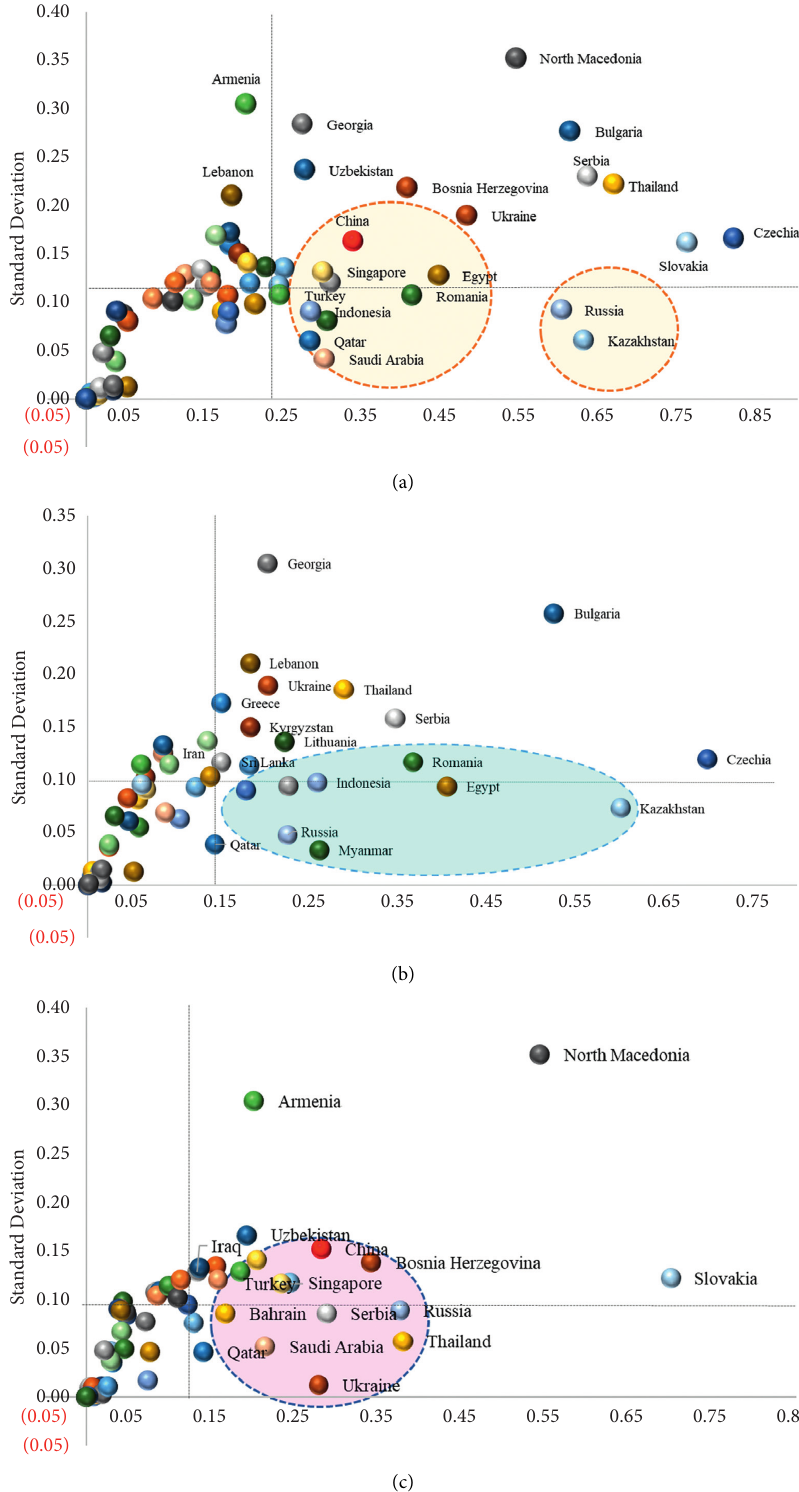
Figure 8: Scatter of EVC and SD for the Belt and Road countries. (a) Total EVC. (b) EVC_out. (c)